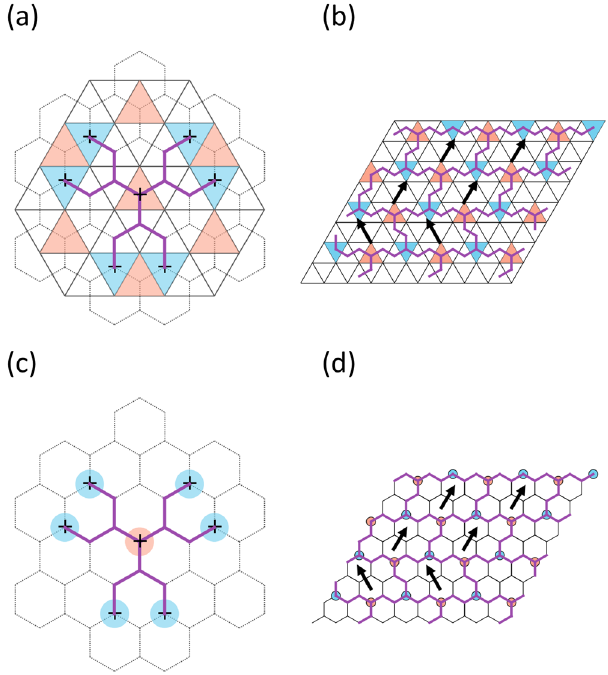
Fig. 3 Visualization of the J 4 interaction range, and the J 4 -optimal state Fig. 4 Monte Carlo simulation results. a A ground state of the "no- in two representations. The red and blue colorings correspond to Wannier touching" plus J 4 model, found through Monte Carlo with periodic states (WSs) on the AB and BA sublattices, respectively. a The red ffiffiffi p ffiffiffi p boundary conditions. This state is equivalent to that predicted in Fig. 3b, d, ´ triangles represent a 3 3 state. With respect to the central red but does not display freedom in the bricks' slant directions. b Entropy of the triangle, there are six possible J 4 neighbors, shown by the blue triangles. "no-touching" model, with J 4 perturbation, as a function of temperature, Only three of the six J 4 locations can be simultaneously occupied. b A neglecting spin and valley degrees of freedom. The temperature is reported con fi guration with the maximum number of three J 4 neighbors per state, in units of V 3 , which represents the strength of the repulsive Coulomb and thus the lowest possible energy. The purple line segments mark pairs of interaction for third-nearest neighbor Wannier states (see Supplementary states that are coupled by the J 4 interaction. The lines of J 4 couplings form Note III for the de fi nition of V 3 an anisotropic emergent hexagonal, or "brick", lattice. The nematicity arises from the rotational symmetry breaking in the spatial arrangement of the WSs. c , d Same as panels a and b , but in the WS center site representation.